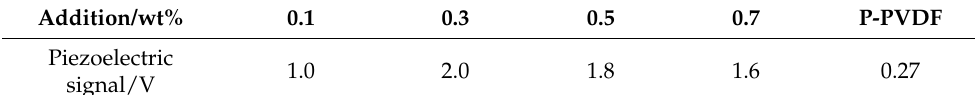
Figure 10. Piezoelectric signal of the fibers membrane at different addition of AgNO 3 : ( a ) the addition of 0.1 wt%; ( b ) the addition of 0.3 wt%; ( c ) the addition of 0.5 wt%; ( d ) the addition of 0.7 wt%. Table 4. Piezoelectric signal of the fiber membrane at different loading of AgNO 3 .